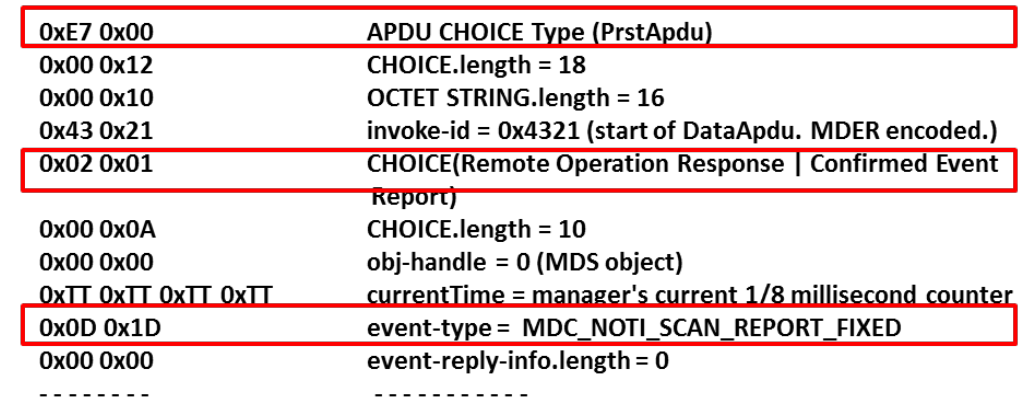
Figure 6. Measurement data transmission from PHD to